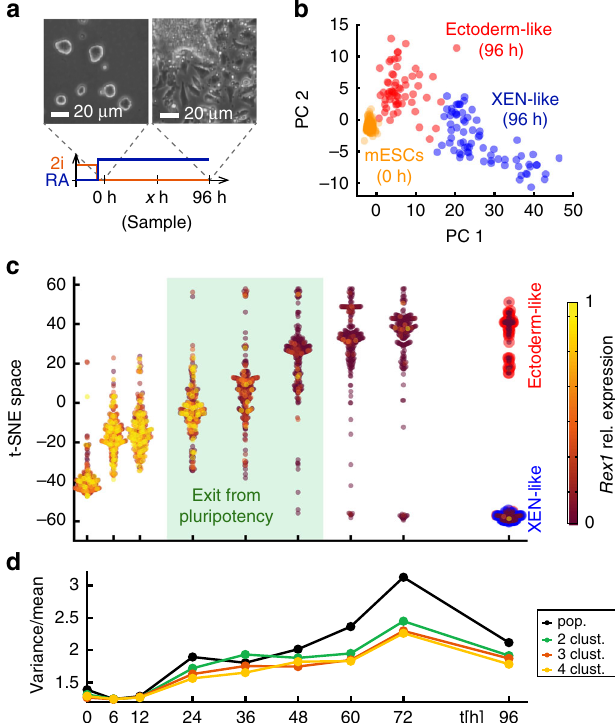
Fig. 1 Single-cell RNA-seq revealed an RA driven lineage transition of mESCs towards ectoderm- and XEN-like cells. a Scheme of the differentiation protocol with phase contrast images of cells growing in 2i/L (0 h) and after 96 h of exposure to 0.25 µ M RA in N2B27 medium. b Principal component analysis of single-cell expression pro fi les of mESCs and cells after 96 h of RA exposure. Principal components were calculated across all cells and time points. Cells were placed in the space of the fi rst two principal components (PC 1 and PC 2). Each data point corresponds to a single cell. Two robust clusters identi fi ed by k-means clustering and stability analysis are shown in red (ectoderm) and blue (XEN), respectively. mESCs are shown in orange. c t-SNE mapping of single-cell expression pro fi les. The single-cell RNA-seq data (SCRB-seq) for all cells and time points were mapped on a one-dimensional t-SNE space, which preserved local similarity between expression pro fi les, while reducing dimensionality. Each data point corresponds to a single cell. Data points for individual time points are shown in violin plots to re fl ect relative frequency along the t-SNE axis. The color of each data point indicates Rex1 expression (relative to maximum expression across all cells). For the 96 h time point, two robust clusters (found by k-means clustering and stability analysis) are indicated with red or blue edges, respectively. d Single-cell gene expression variability quanti fi ed as the variance over the mean (Fano factor). The Fano factor was calculated either for the whole population or subpopulations of cells de fi ned by k-means clustering using 2,3 or 4 clusters. Clustering was carried